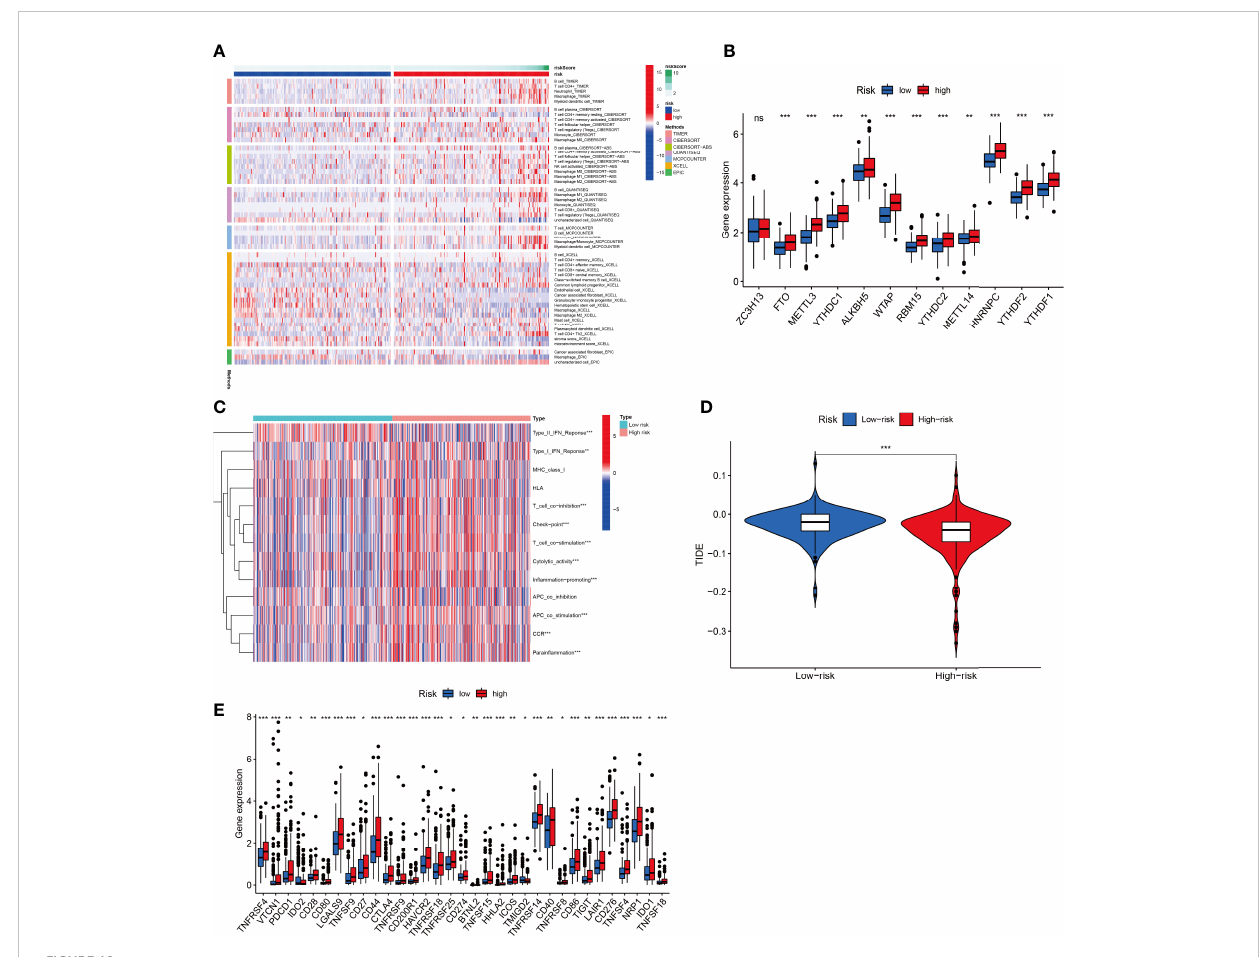
FIGURE 10 Combined F-NLR signature model to predict immunotherapy responses. (A) Heatmap of immune responses in the high- and low-risk groups based on different algorithms. (B) Expression of m 6 A-related genes in the high- and low-risk groups. (C) Single-sample gene set enrichment analysis of the association between immune cell subpopulations and related functions in the high- and low-risk groups. (D) TIDE model results for the high- and low-risk groups. (E) Expression of immune checkpoints in the high- and low-risk groups. (* P <0.05, ** P <0.01, *** P